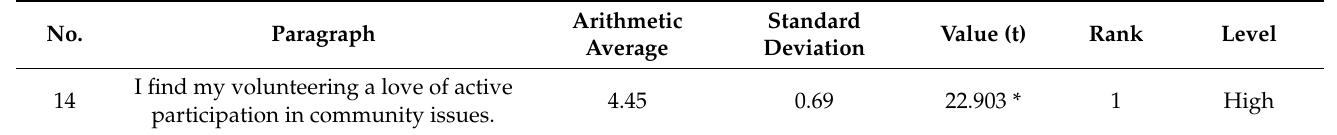
Table 3. Calculation averages and test (t) of the responses of the members of the study sample to the level of “skills acquired by volunteers through volunteering during the emerging COVID-19 pandemic” ranked downwards by arithmetic